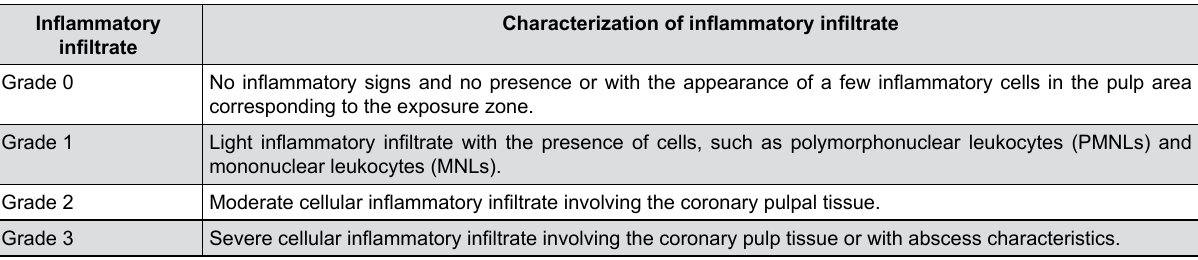
Figure 2- Classification of cellular inflammatory infiltrate Pulp tissue disorganization